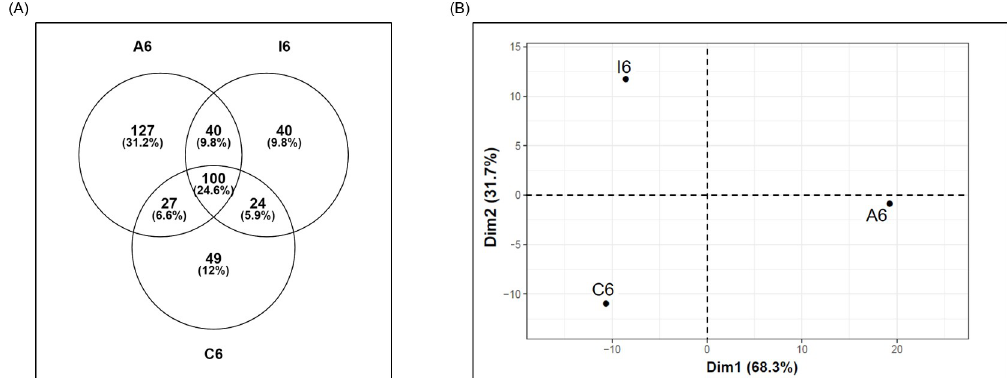
Fig 5. Comparative analysis of proteins detected in fraction 6 of Active, Inactive, and Control samples. (A) Venn diagram showing the distribution of the proteins detected in fractions 6 datasets. (B) Principal component analysis (PCA) plot of samples based on fraction 6 datasets, i.e. the median intensity values of the proteins identified in fractions 6 of the replicas of each sample. The position of conditions in the two generated main components is plotted. Variability explained by the first and second components of the PCA is indicated between